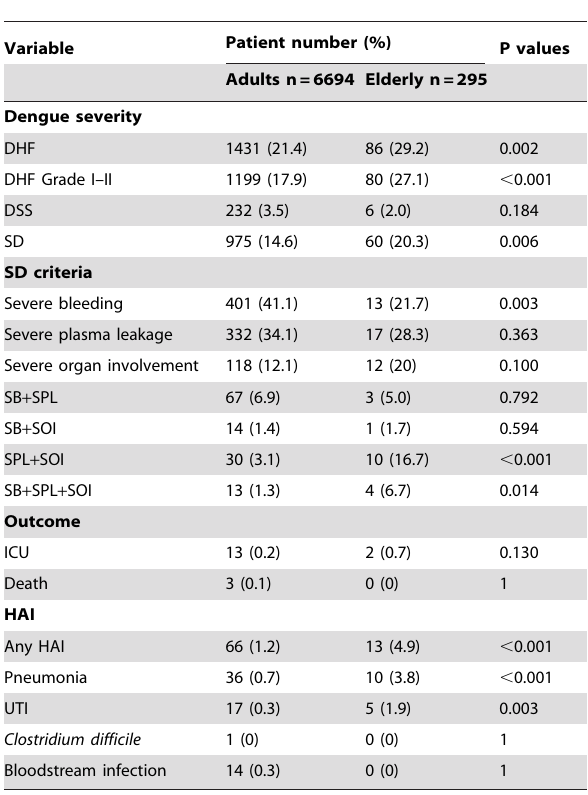
(Table 1) including hypertension, diabetes, chronic renal impair- ment and chronic obstructive pulmonary disease. As expected a high Charlson co-morbidity score ( . 3) was significantly more